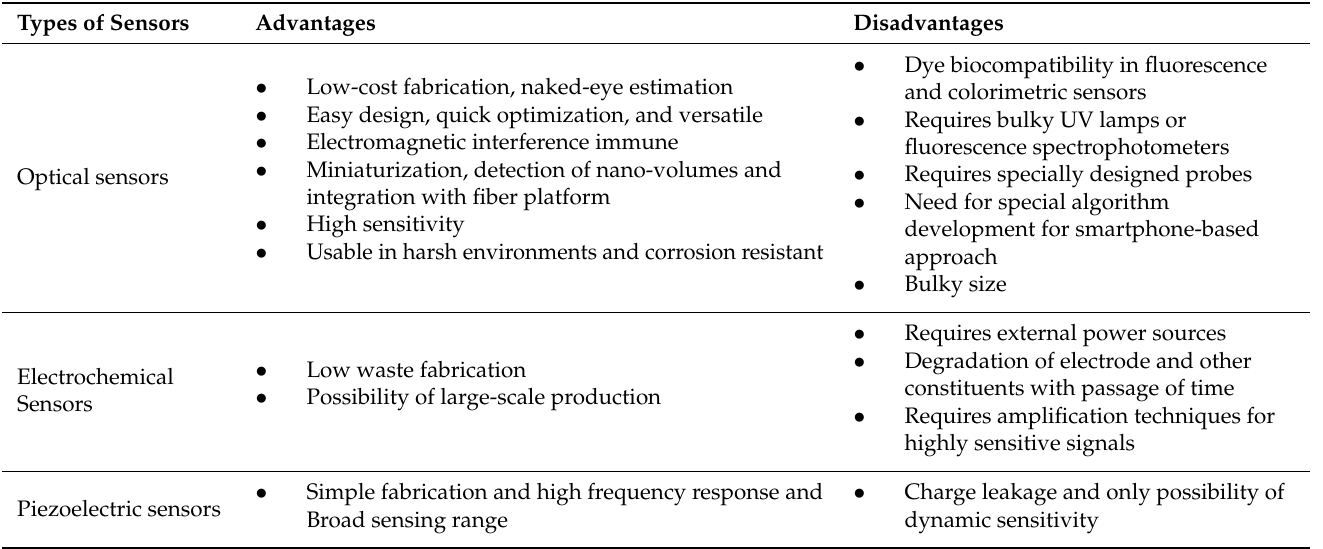
Table 3. Comparison of optical and conventional wearable sensors for different health monitoring